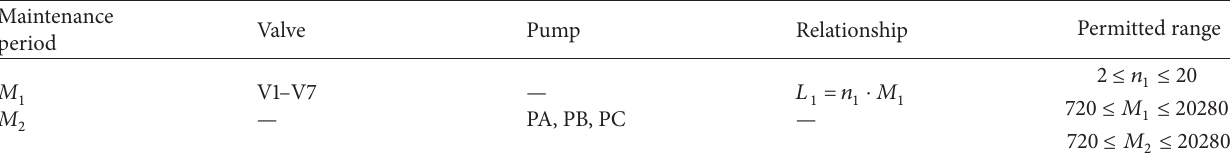
Table 7: Constraint on preventive maintenance intervals.